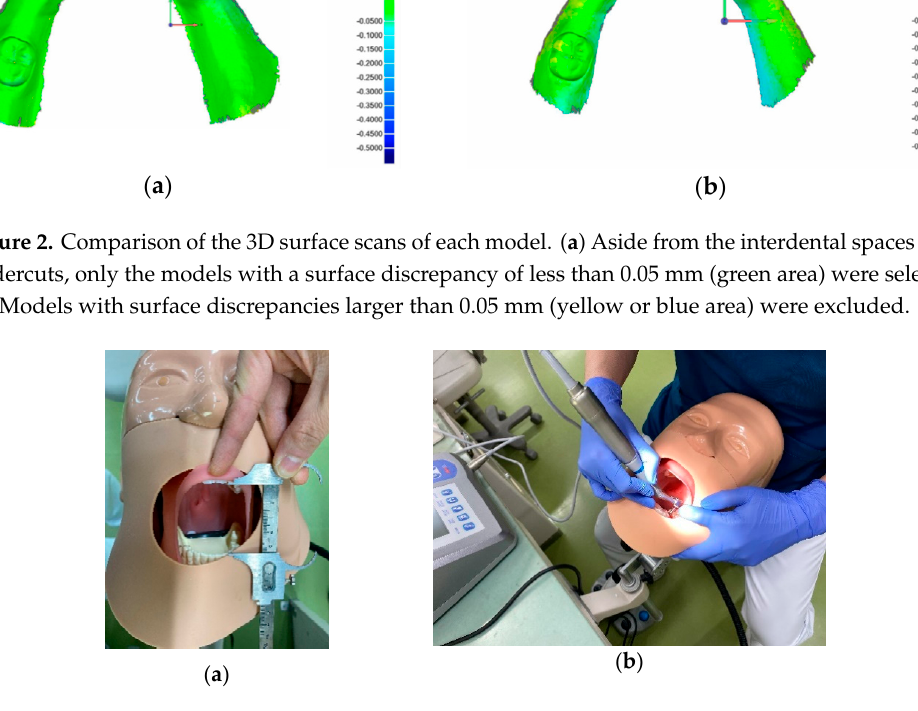
Figure 3. ( a ) Mouth opening of the manikin was set to 47 mm. ( b ) Laboratory setting of the simulation guided implant surgery.